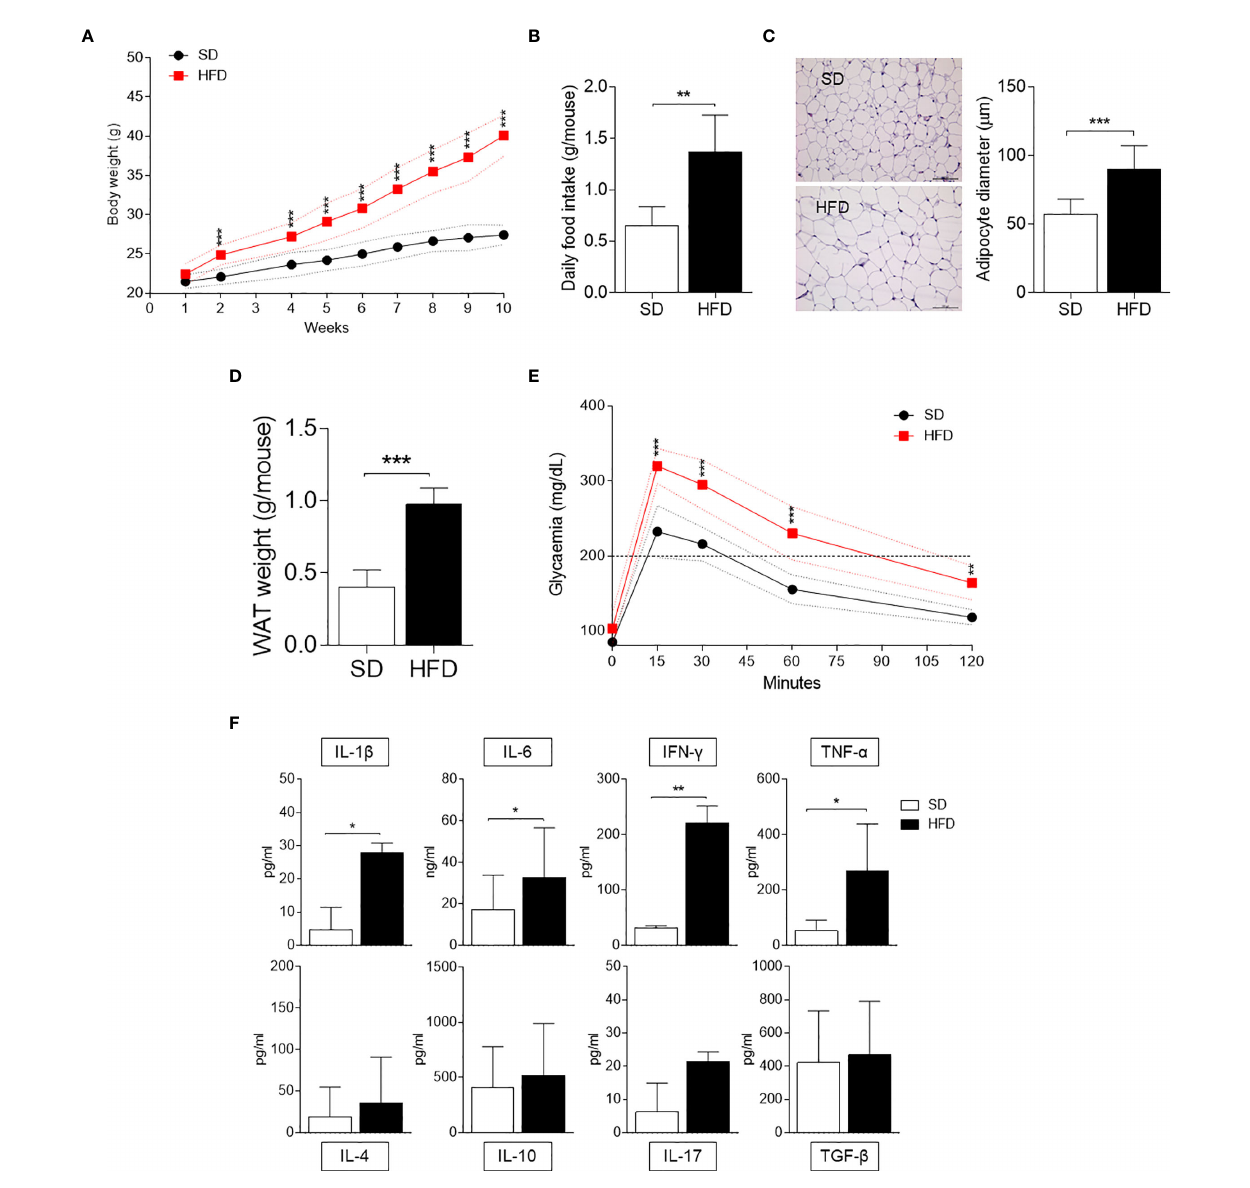
FIGURE 1 | Obesity and in fl ammatory parameters of HFD-fed mice. (A) Body weight (g) of 6-wk male mice fed with high-fat diet (HFD, n = 10) for 10 wk compared with gender- and age-matched controls fed with a standard diet (SD, n = 10). (B) Average food intake (g) per mouse per day ( n = 10, from two independent experiments). (C) Hematoxylin and eosin staining of visceral WATs (left panel, scale bars of 100 m m.). Analysis of adipocyte diameter (right panel). (D) Average WAT weight (g) per mouse ( n = 5, from two independent experiments). (E) Intraperitoneal glucose tolerance test (IPGTT) after 10 weeks of HFD ( n = 5, from two independent experiments). Glycaemia (mg/dl) was measured at different time points (0, 15, 30, 60, and 120 min) from the administration of glucose. (F) Levels of cytokines secreted by SVF WAT cells in 24-h culture supernatants. Results are represented as means ± S.D ( n = 3 biological replicates, from two independent experiments). * p < 0.05, ** p < 0.01, *** p < 0.001 HFD versus SD, two-tailed unpaired Student ’ s t test and multiple Student ’ s t test per row, corrected by post hoc Sidak-Bonferroni ’ s